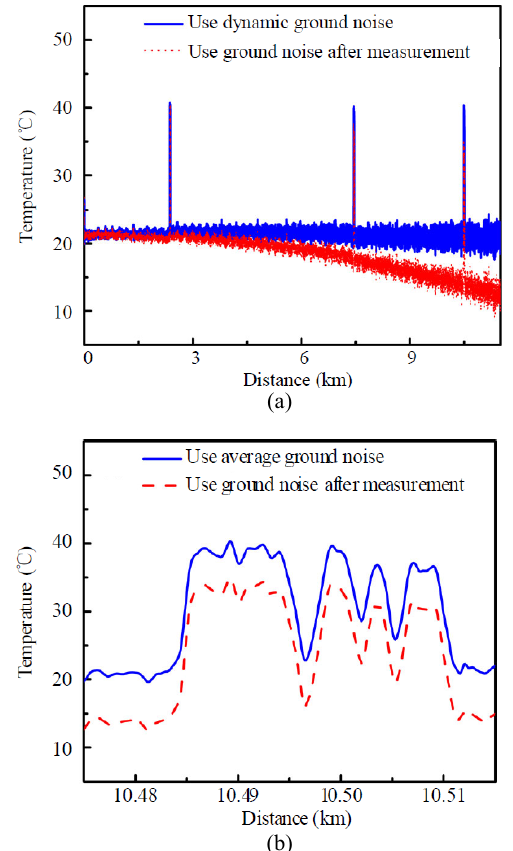
Fig. 6 Measurement results by using dynamic ground noise and constant ground noise: (a) overall-distribution alone the fiber and (b) at Test